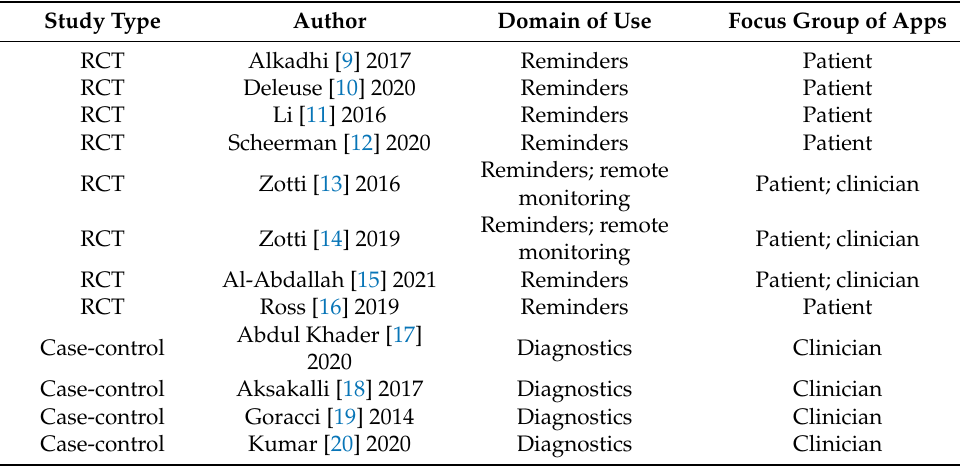
Table 1. The characteristics of current studies about apps used in orthodontics ( n = 20). Study